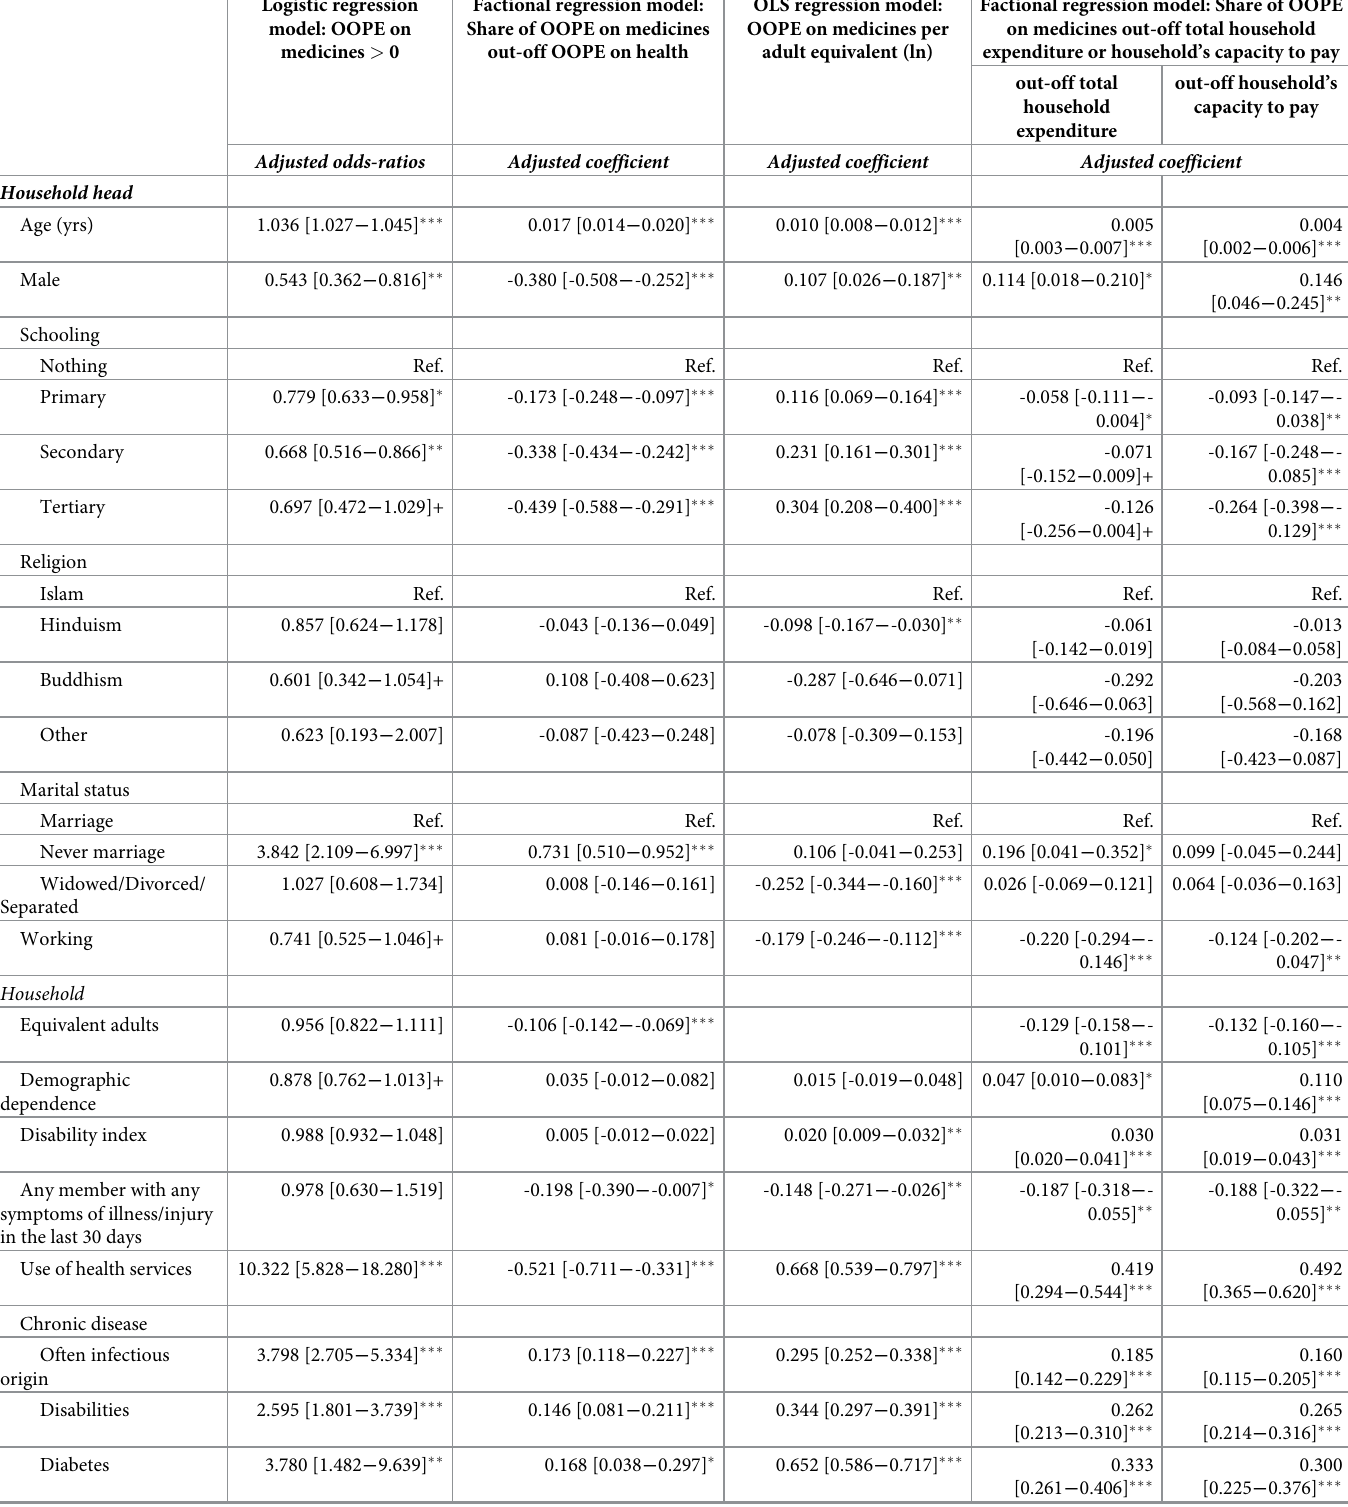
Table 3. Factors associated with OOPE on medicines. HIES, Bangladesh,